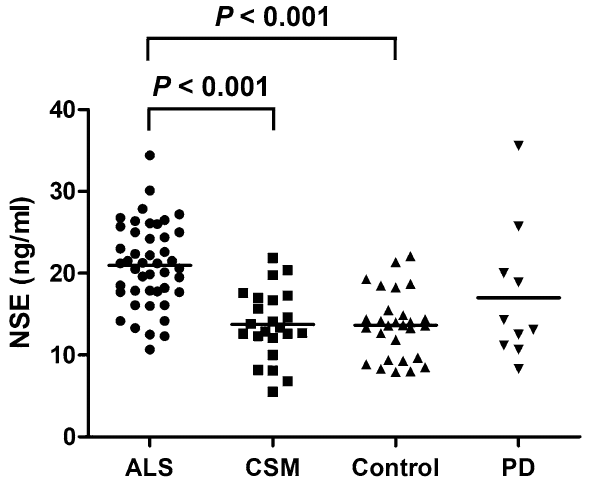
Figure 1. CSF NSE levels of the ALS, CSM, control, and PD groups. The solid line represents the mean CSF NSE levels of each group. ALS amyotrophic lateral sclerosis, CSF cerebrospinal fluid, CSM cervical spondylotic myelopathy, NSE neuron-specific enolase, PD Parkinson’s